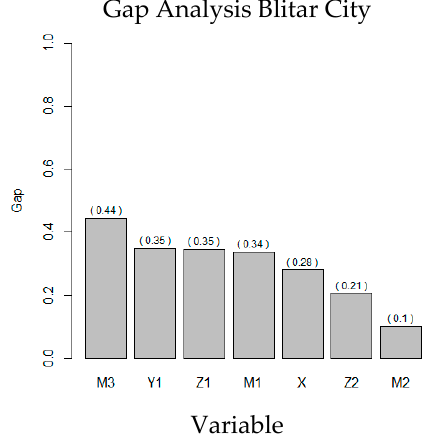
Figure A9. Bar Diagram of Gap Analysis of Blitar Regency.